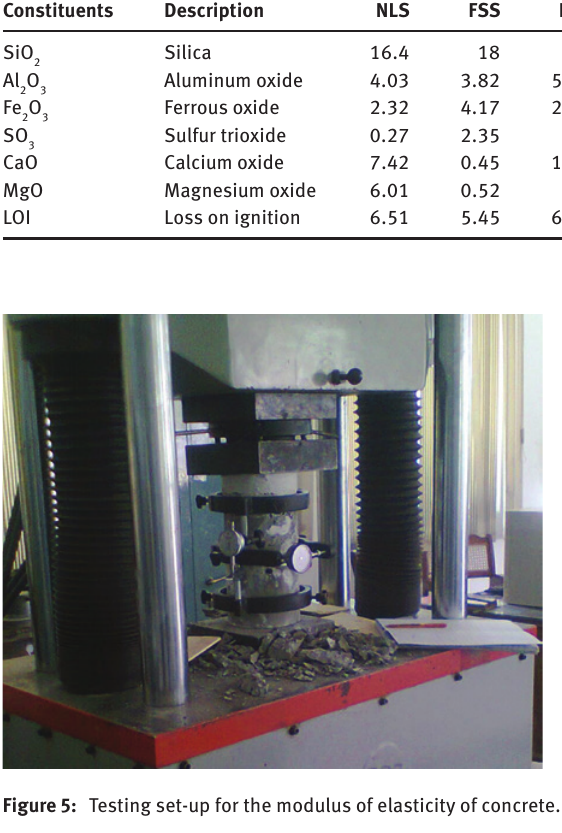
Figure 5: Testing set-up for the modulus of elasticity of concrete.